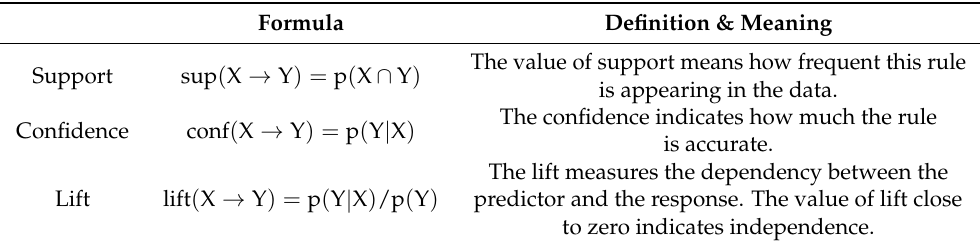
Table 1. Definition of formula and explanation of support, confidence, and